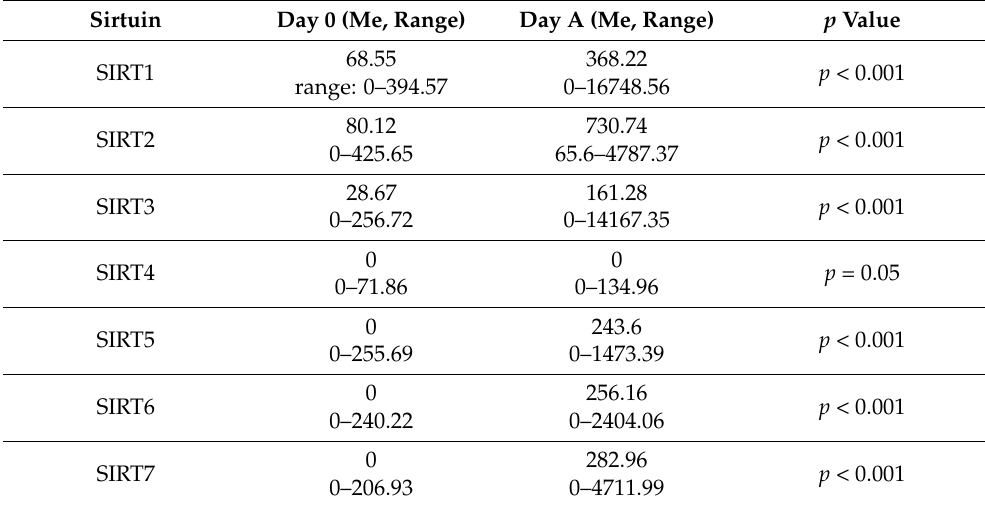
Table 3. Alterations in sirtuin expression (copies/200 µ L serum, median values) before mobilization regimen (day 0) and on the day of the first apheresis (day